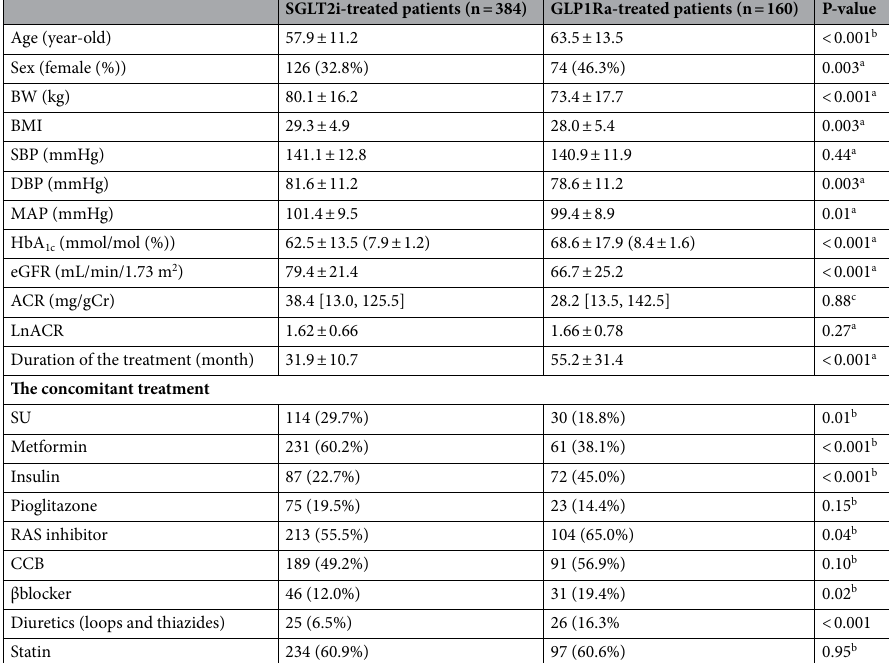
Table 1. The clinical characteristics of SGLT2i-treated and GLP1Ra-treated patients at baseline. Values represent mean ± standard difference, n (n/total %), or medium [25% quantile, 75% quantile]. BMI body mass index, BW body weight, CCB calcium channel blocker, DBP diastolic blood pressure, eGFR estimated glomerular filtration rate, GLP1Ra glucagon-like-1 receptor agonist, HbA 1c glycated hemoglobin A 1c , LnACR logarithmic value of urine albumin-to-creatinine ratio, MAP mean arterial pressure, RAS renin aldosterone system, SBP systolic blood pressure, SGLT2i sodium glucose cotransporter inhibitor, SU sulfonyl urea. a Chi square test. b Unpaired t test. c Mann–Whitney rank-sum